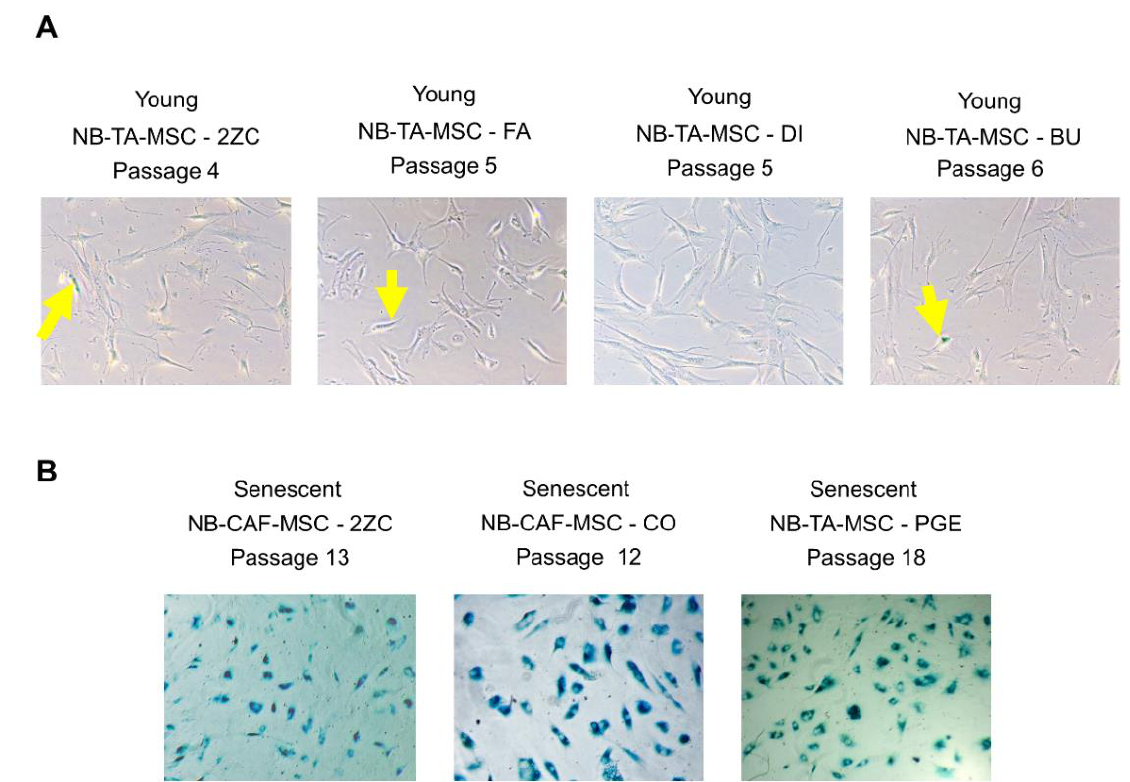
Figure Figure 2. Staining with the senescence-associated beta-galactosidase (SA- β -gal) assay of young/pro- liferative and growth-arrested NB-TA-MSC. ( A ) Representative images of young/proliferating NB- TA-MSC and ( B ) Growth-arrested NB-TA-MSC stained with SA- β -gal at the indicated culture pas- sages. The senescent cells appear stained in blue. Images represent 10× with phase contrast optical microscope of n = 3 independent experiments. Yellow arrows indicate rare β -gal+ cells in young proliferating NB-TA-MSC cells.